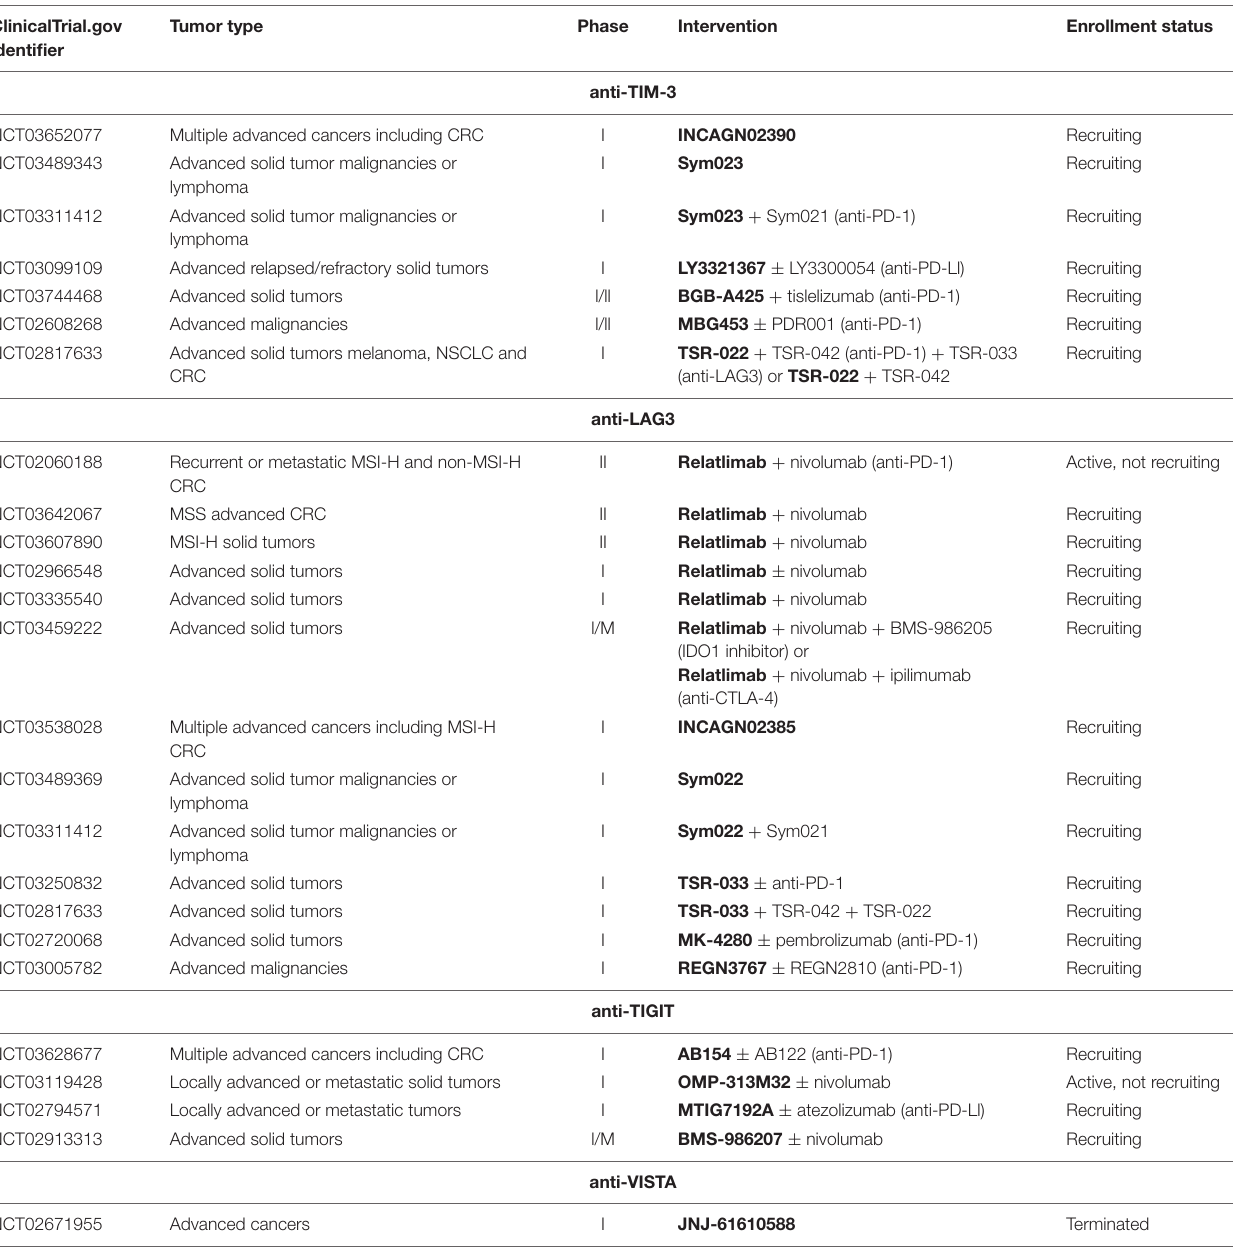
TABLE 1 | Overview of some of the ongoing clinical trials investigating TIM-3, LAG-3, TIGIT, and VISTA inhibitors in advanced cancers including CRC. ClinicalTrial.gov